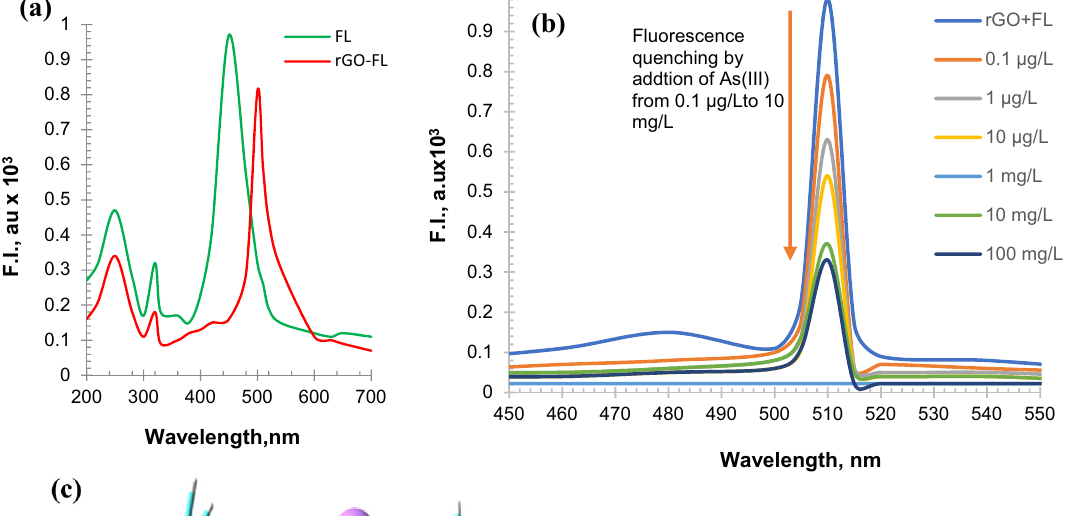
rGO–FL nanoparticles form a flexible bi-layer structure in which the –COOH, –OH and =O functionalities of